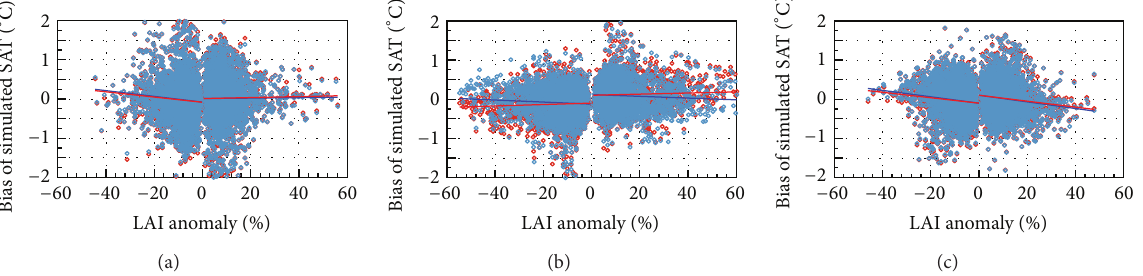
Figure 7: The maximum and minimum LAI anomalies and the corresponding biases of simulated surface air temperature (SAT) from the DYC (blue circle) and FIX (red circle) simulations (DYC minus observation and FIX minus observation) for spring (a), summer (b), and autumn (c),